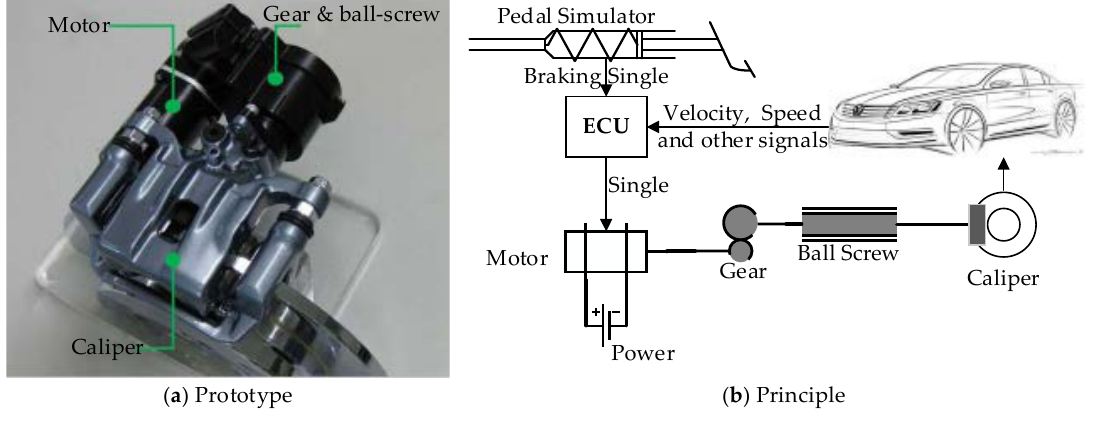
Figure 4. Electro-mechanical brake.